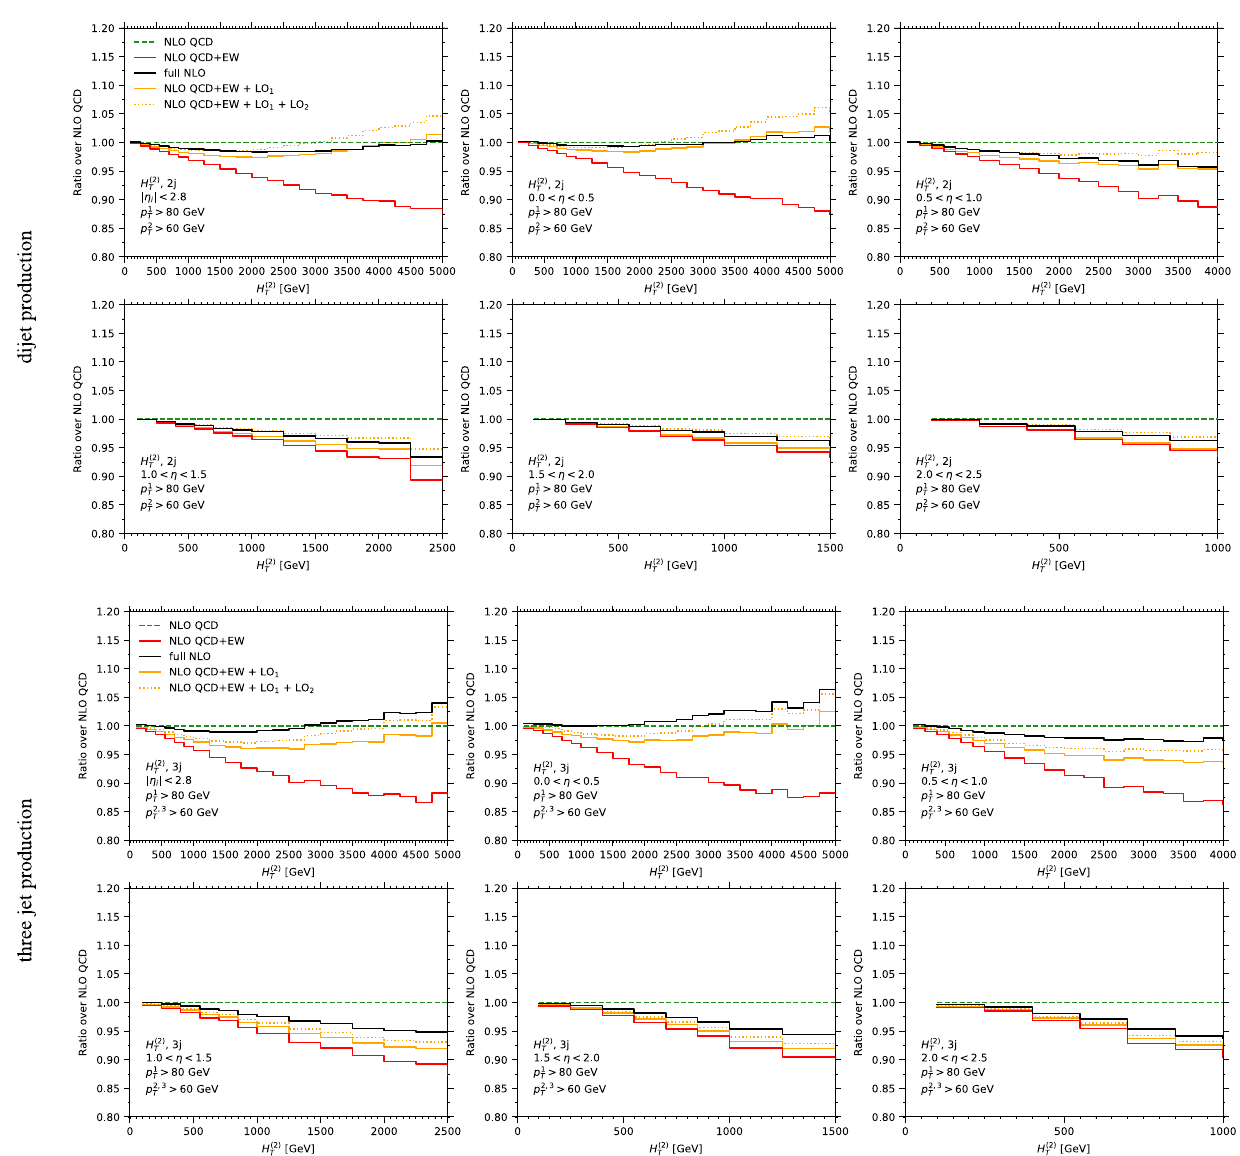
η = | η − η | / 2. Shown are the NLO QCD, NLO QCD + EW and 1 2 full NLO result as well as the subleading Born contributions LO 1 and LO